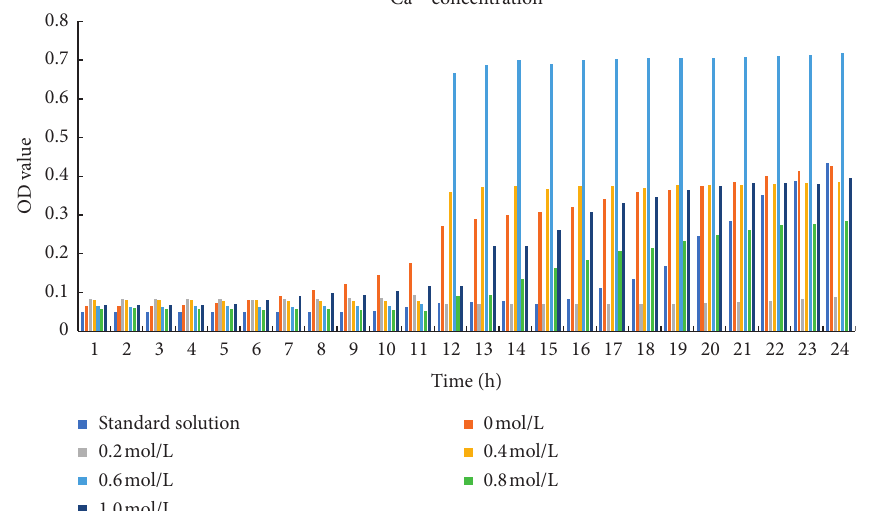
Figure 3: Effects of Ca 2+ concentration on Bacillus sphaericus .